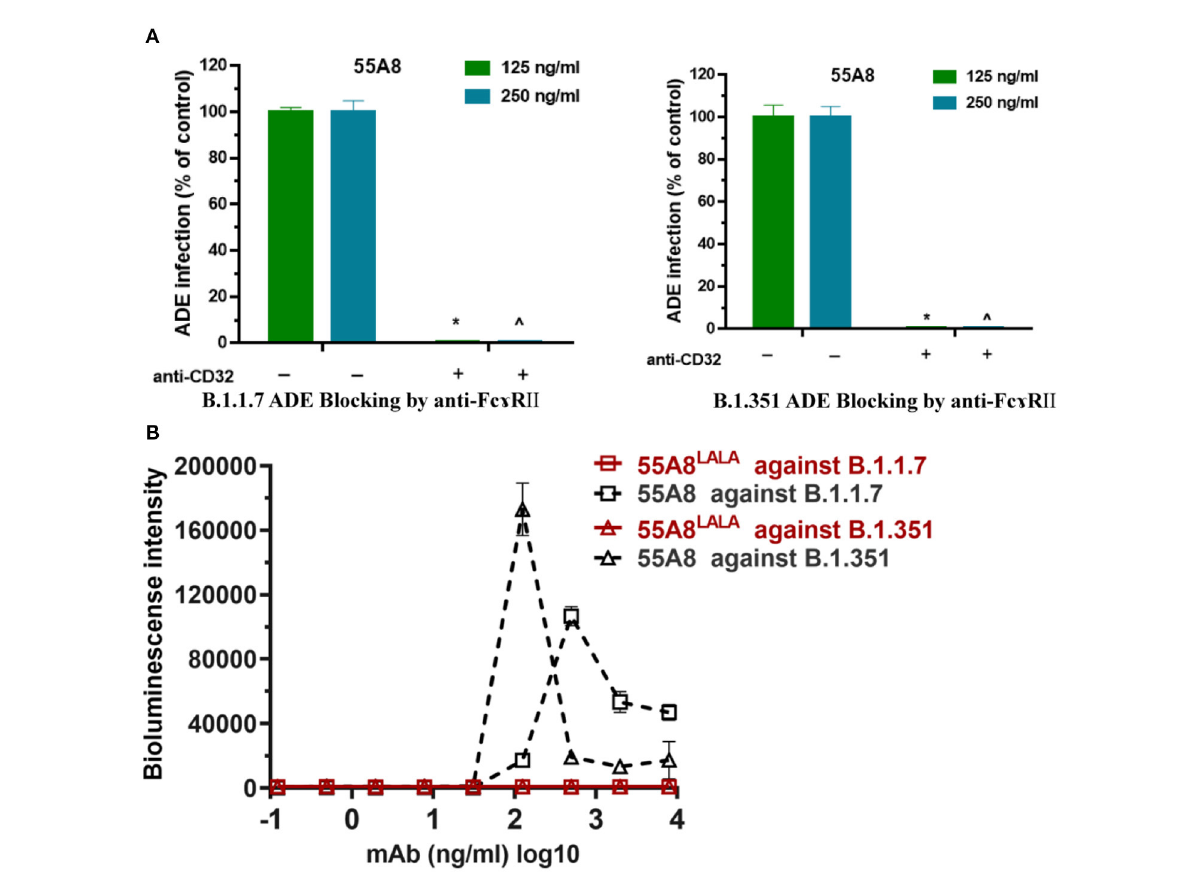
FIGURE5 The ADE effects mediated by the neutralizing antibody 55A8 depend on Fc γ RII. (A) Assessment of ADE activities of the neutralizing antibody 55A8 for the epidemic variants (including B.1.1.7 and B.1.351) with or without anti-CD32 (blocking Fc È R II). The SARS-CoV-2 B.1.1.7 and B.1.351 pseudoviruses were preincubated with 125ng/ml and 250ng/ml of 55A8, and their mixtures were added to Daudi cells to evaluate their ability to enhance infection. The percentage of control-represented ADE infection was quantified by luminescence meter and normalized to the reference groups without anti-CD32 produced in parallel, and the anti-CD32 was diluted to 40ng/ml. (B) Assessment of ADE activities of 55A8 LALA for epidemic variants, including B.1.1.7 and B.1.351. Pseudoviruses were preincubated with serially diluted 55A8 or 55A8 LALA , and their mixtures were added to Daudi cells to evaluate their ability to enhance infection. RLU values resulting from infection with variant pseudotyped viruses were quantified by a luminescence meter. Data for each NAb were obtained from a representative infectivity experiment of three replicates, presented as the mean values ± SEM, and p -values were calculated via two-sided Student’s t -test. * p < 0.05 vs. the 125ng/ml of 55A8 group without blocking anti-Fc γ RII antibody, and ∧ p < 0.05 vs. the 500ng/ml of 55A8 group without blocking anti-Fc γ RII